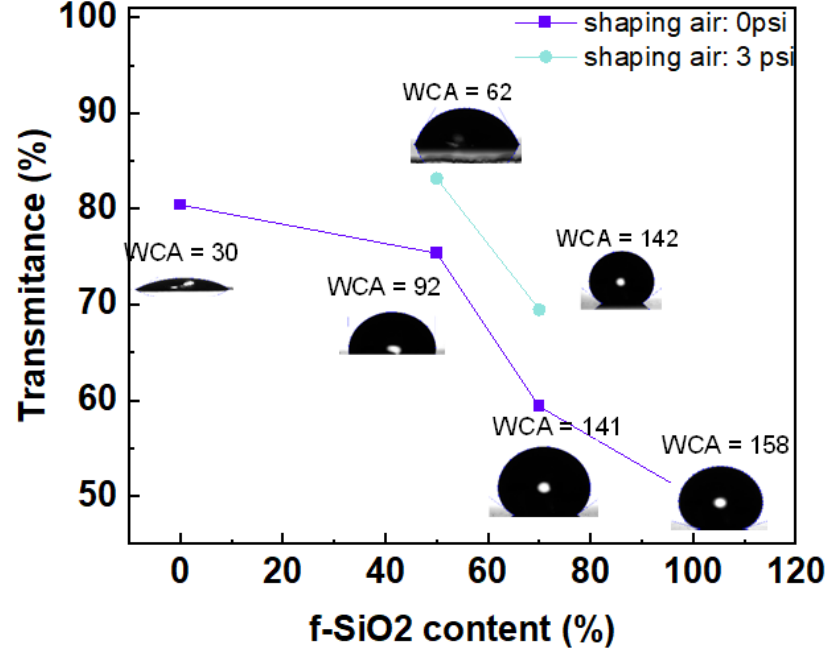
Figure 10. Value of average transmittance of the coating varies with the content of f-SiO 2 , the corresponding WCA images, and the values of samples sprayed with shaping air of 0 psi and 3 psi.